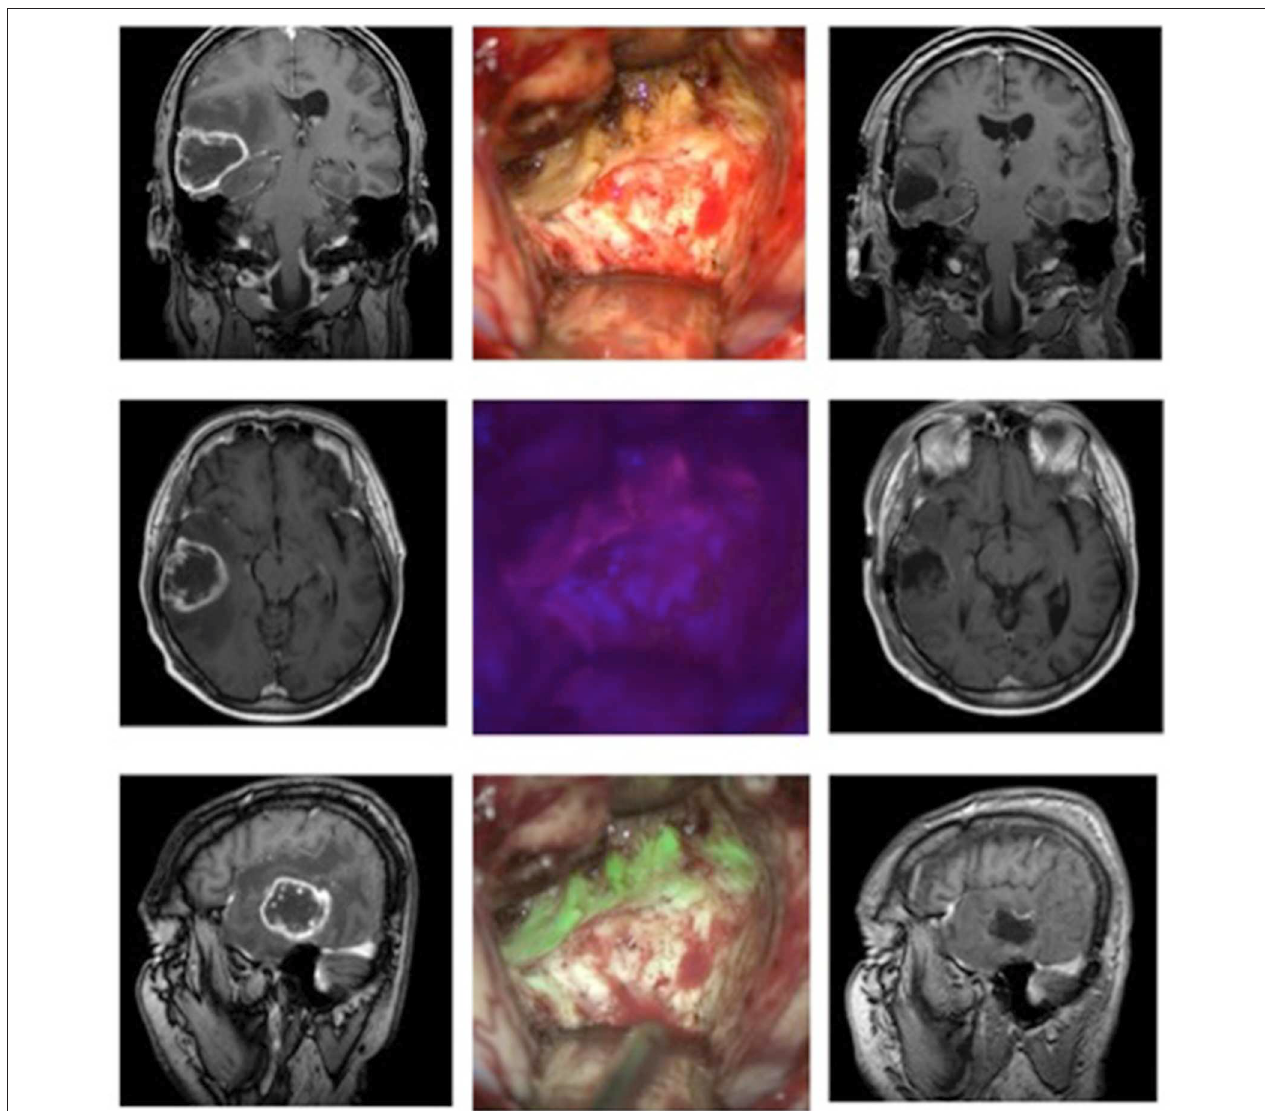
FIGURE 1 | Glioblastoma in a 53-year-old patient. The left column shows the MRI images (T1 weighted with contrast, from top to bottom: coronary, axial, sagittal) before the operation, the right column the postoperative MRI. In the middle column, the top picture shows the surgical field under white light, below it under blue light, and at the bottom the fusion of both images in the